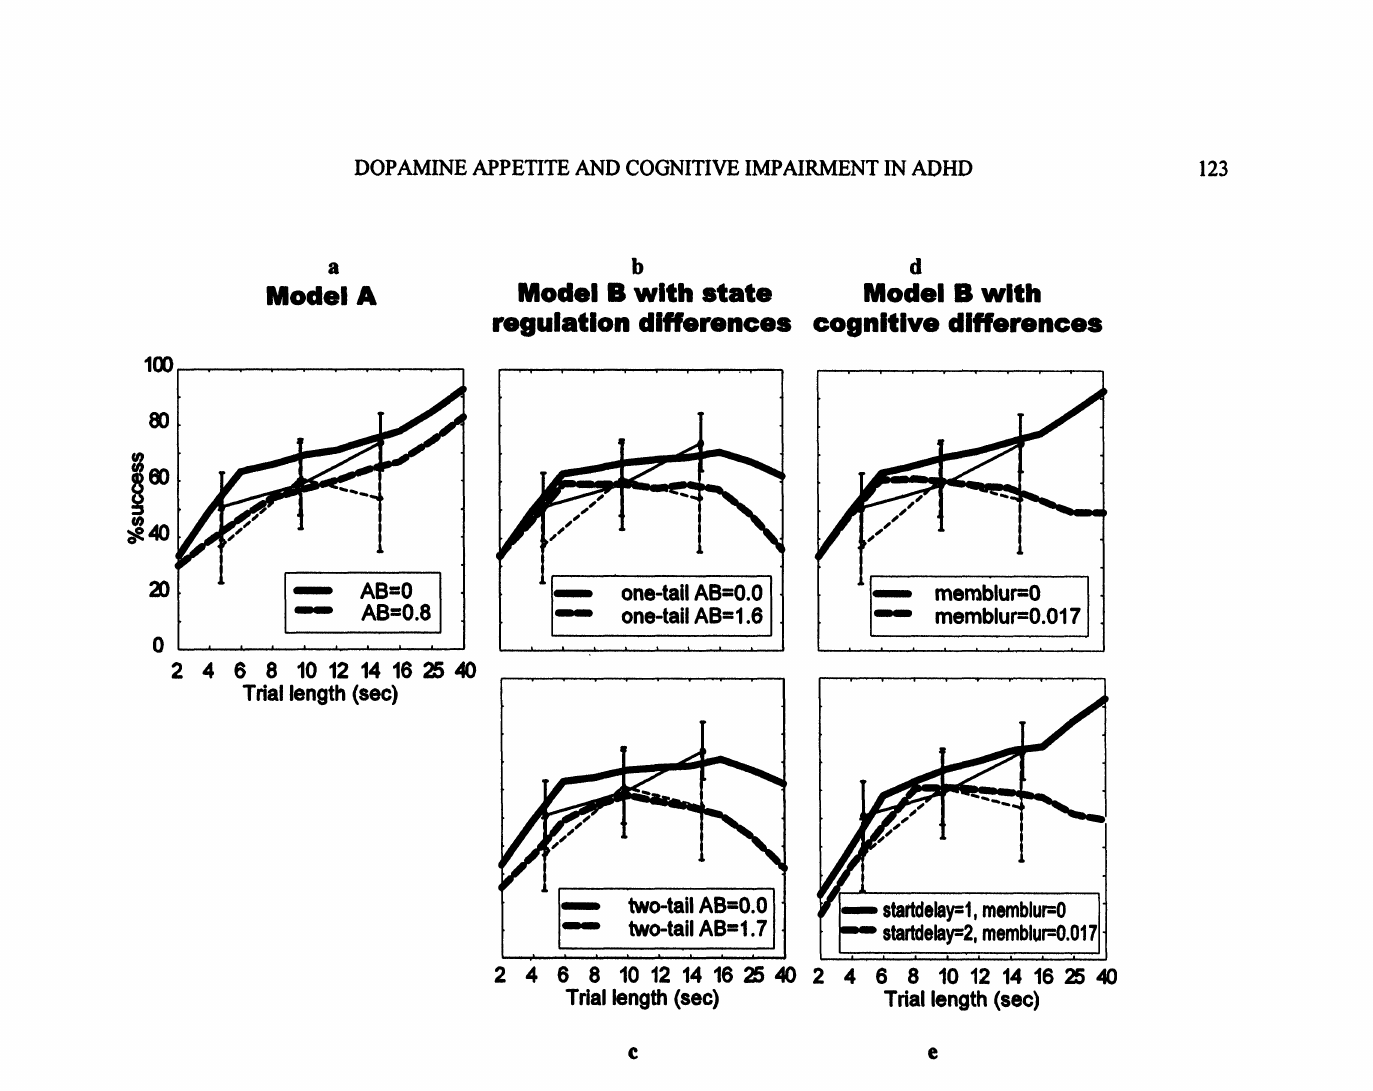
Fig. 2: Simulations of the Matching Familiar Figures Task (MFFT), compared with real data. Each graph shows the means and standard deviations from Sonuga-Barke (2002) Study 1, redrawn unchanged in every graph as thin lines (solid=control; dashed=ADHD). Superimposed on this, each graph shows the performance of two simulated groups of children, as thick lines (solid--model of controls; dashed--model of ADHD). All the simulations use the same values for all parameters, except for the one or two explicitly manipulated for each figure and shown in the legend boxes, and Model A does not include any working memory deficit, delay at the start of trials, or state regulation mechanism. Each simulated data point results from 5000 trials. Note that the right ends of the x-axes are compressed. (a) Effect on the model of fixed difference in Action Bias. (b) Effect on the model, of fixed difference in response to reward deficit, increasing Action Bias. (c) Effect on the model, of fixed difference in response to nonoptimal reward rate, increasing Action Bias. (d) Effect on the model, of reducing the retentiveness of working memory. (e) Effect on the model, of two fixed differences: start-trial delay and working memory retentiveness. Abbreviations: AB Action Bias (see text). One-tail AB: The extent to which non-optimal reward rate increases the Action Bias. This is "one-tailed" because reduction, but not increase in the reward rate increases Action Bias. Two-tail AB: The extent to which non-optimal reward rate increases the Action Bias. This is "two-tailed" because increase in the reward rate increases Action Bias, just as reduction does. Memblur: the extent of blurring of working memory each second (see Appendix). Startdelay: The number ofseconds not used at the start of each